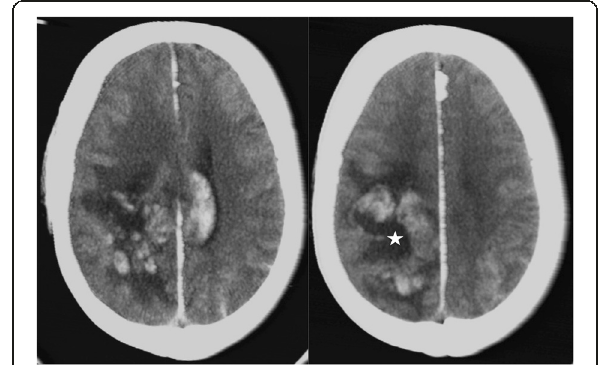
Fig. 6 Axial CT scan without contrast medium injection. Spontaneous nodular hemorrhagic hyperdensity indicating establishment of an intraparenchymal hematoma with hypodense center (star). The right lateral ventricle is clear and the left is laminated. Note the presence of an associated subarachnoid